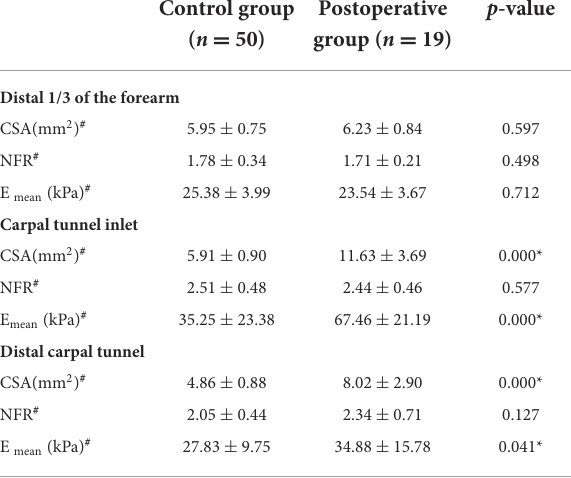
TABLE 4 Conventional ultrasound and shear wave elastography parameters of the control group and the postoperative group. Control group